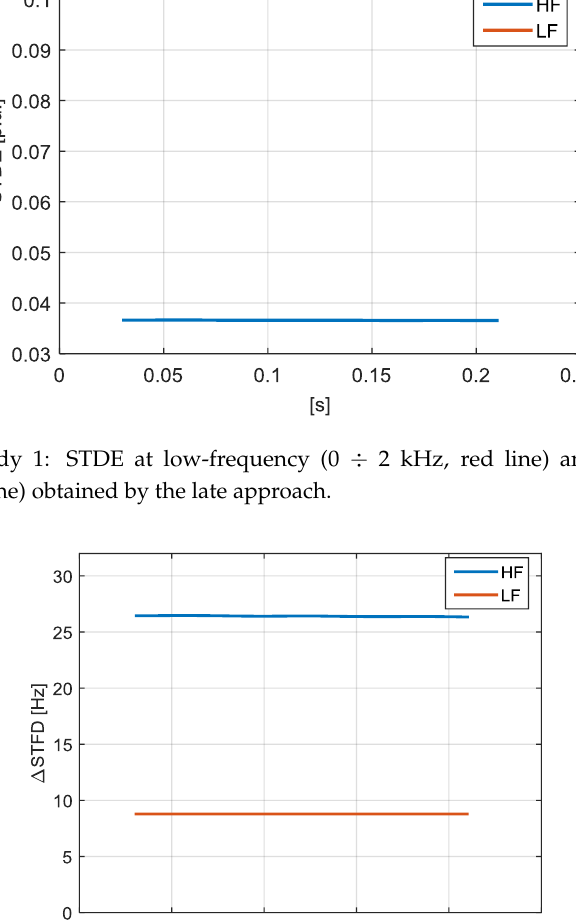
Figure 8. Case study 1: Δ STFD at low-frequency (0 ÷ 2 kHz, red line) and at high-frequency (2 ÷ 150 kHz, blue line) obtained by the late approach.